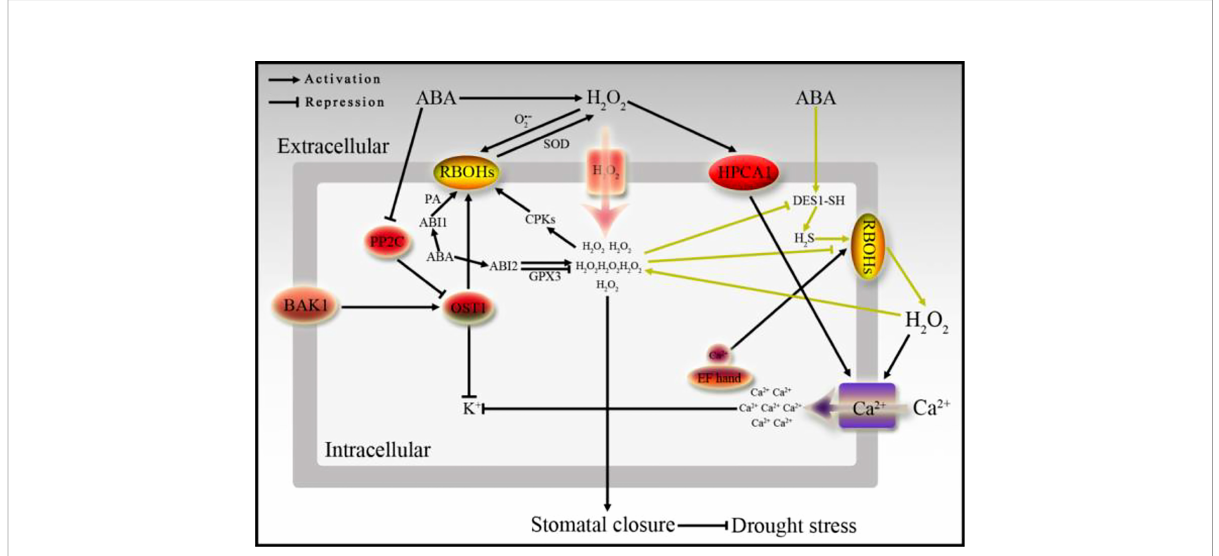
FIGURE 3 The relationship between ABA signaling and H 2 O 2 in stomatal movement. ABA signal is transmitted downward through PP2C and OST1, or ABI1 and ABI2, meanwhile, ABA can promote the generation of H 2 O 2 induced by RBOHs on the plasma membrane, and forms a microcirculation by H 2 S. H 2 O 2 is sensed by the H 2 O 2 receptor HPCA1, and the H 2 O 2 signal is transmitted into the cell to promote Ca 2+ in fl ux, inhibit K + accumulation, and then causes stomata to